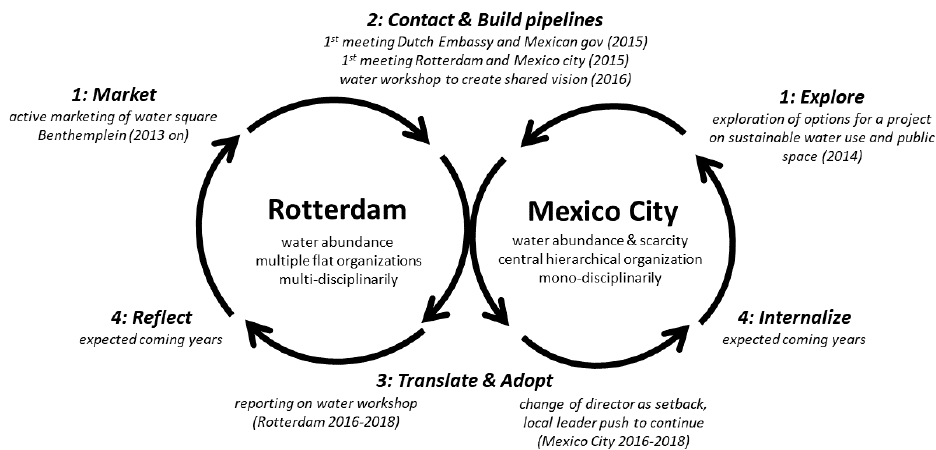
Figure 5. Representation of the process of city-to-city knowledge transfer between Rotterdam and Mexico City related to water squares.